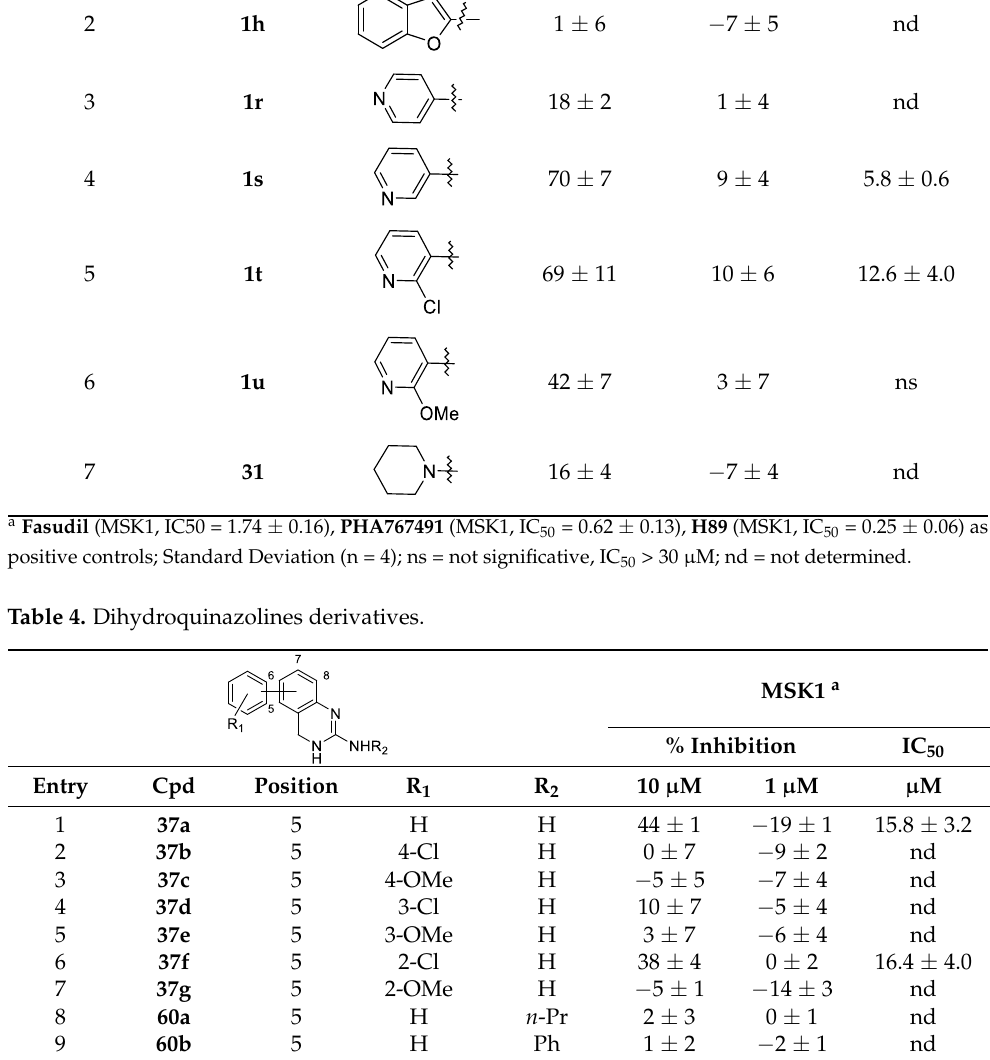
Figure 4. Structurally-related inactive compounds.